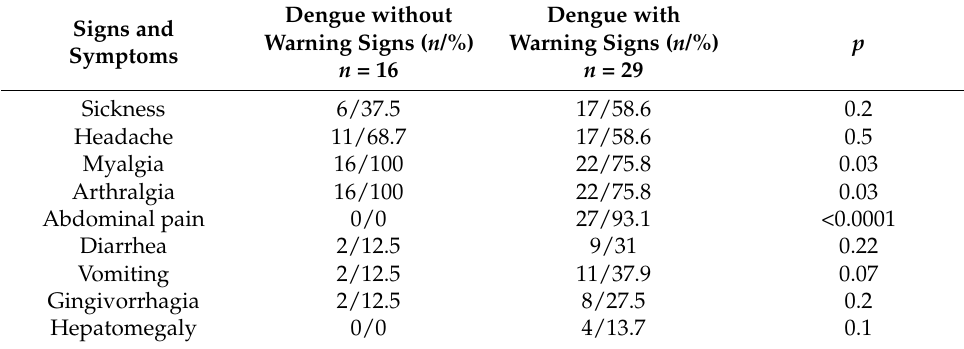
Table 2. Prevalence of clinical manifestations by study